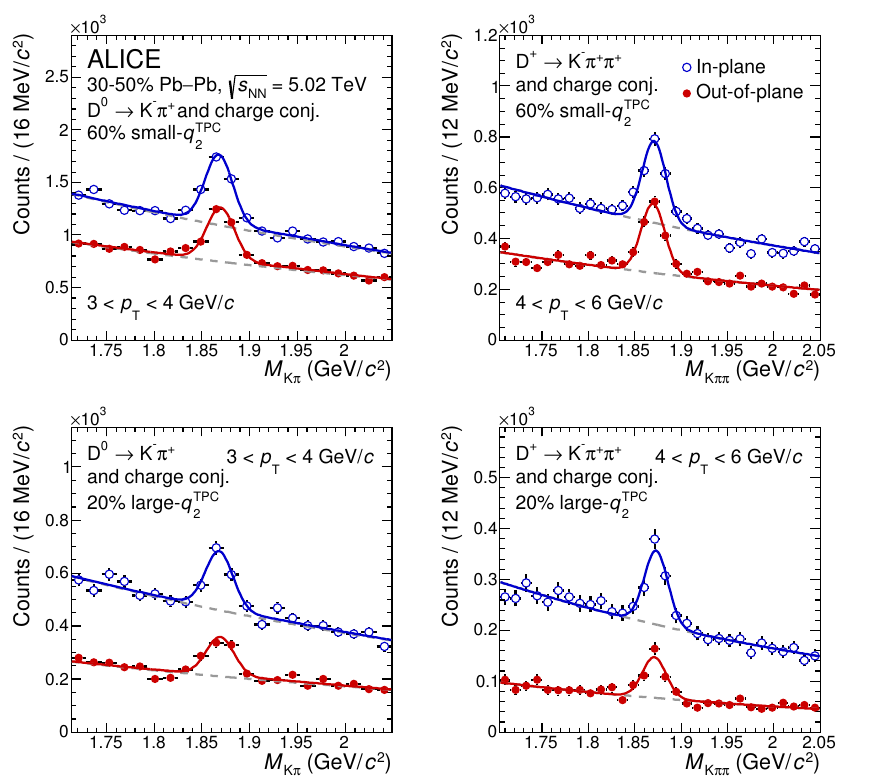
Figure 3 . Invariant-mass distributions of D 0 candidates (left column) and D + candidates (right column) in two p T intervals for the two (cid:1) ’ regions used in the EP method for the 30{50% Pb-Pb p collisions at s = 5 : 02 TeV. The top row shows the distributions for the small- q TPC sample, 2 NN while the bottom row for the large- q TPC sample (see text for details). The solid curves represent 2 the total (cid:12)t functions and the dotted curves the background functions, as described in the text. Examples of invariant-mass (cid:12)ts for the three D-meson species in the unbiased sample in the 10{30% centrality class and for D 0 and D + mesons in the ESE-selected samples in the 30{50% centrality class are shown in (cid:12)gure 2 and (cid:12)gure 3,